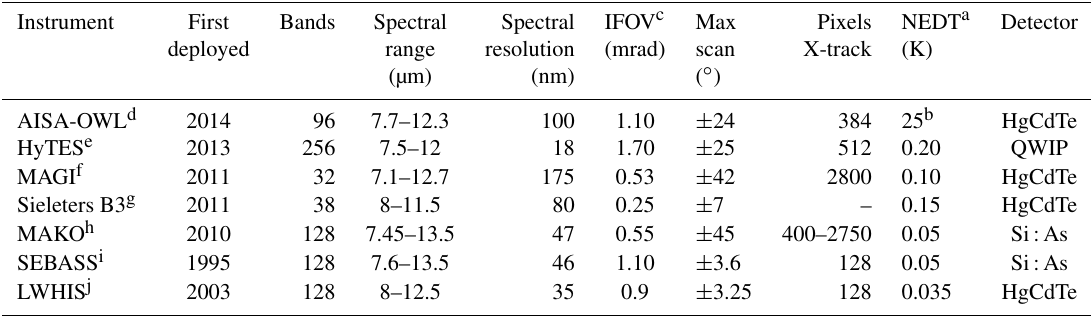
Table 1. Instrument characteristics of well demonstrated airborne hyperspectral long-wave thermal infrared systems. Instrument